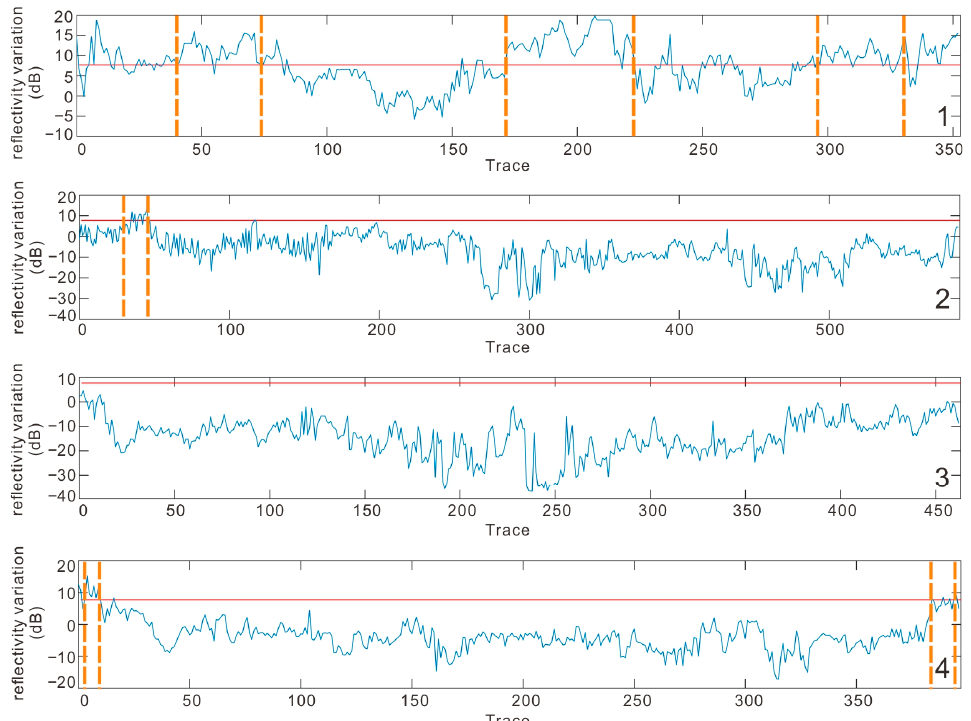
Figure 5. Reflectivity variation plots along four radar profiles calculated using a linear absorption model and the CHINARE 21 radar data; the vertical lines show ∆𝑅 > 7.7 dB area (radar data at the undetermined ice-bedrock interfaces area were removed).